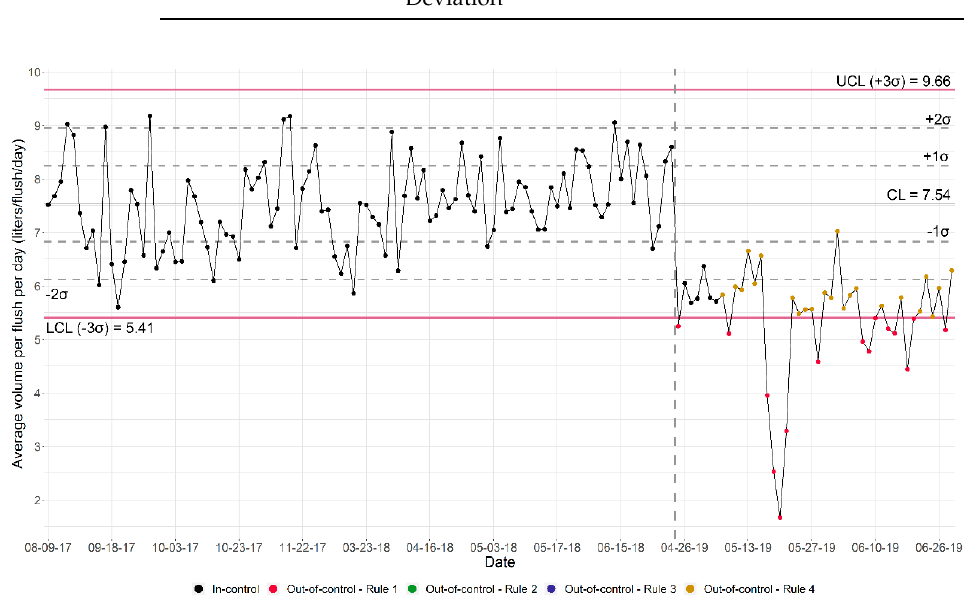
Figure 7. Shewhart Control Chart—Average volume per flush per day (male restrooms).